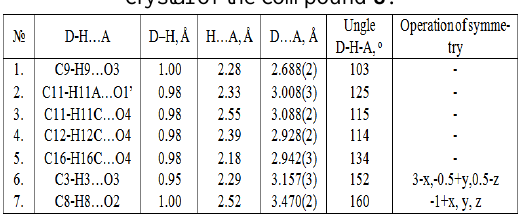
Таble 2. Parameters of intramolecular and intermolecular hydrogen bonds in the crystal of the compound 8